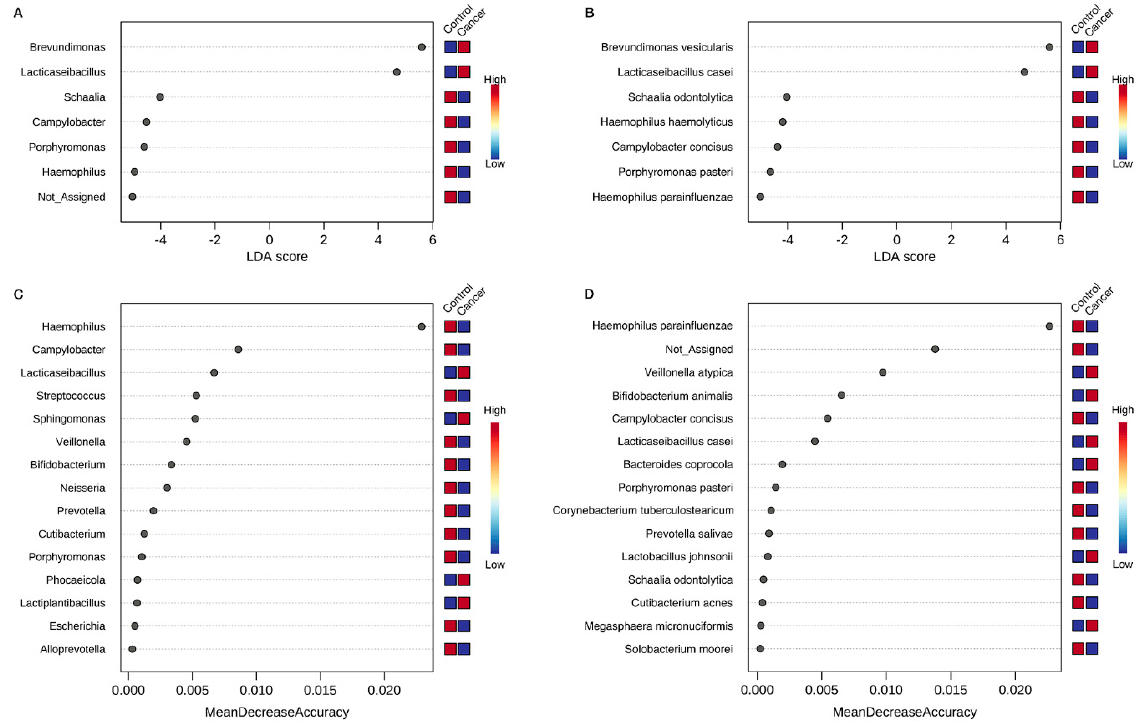
Figure 5. Taxonomic differences between control and cancer groups in linear discriminant analysis effect size (LEfSe) and random forest (RF) analyses. Linear discriminant analysis (LDA) score of differentially expressed bacteria obtained from LEfSe analysis of gastric microbiota in the control and cancer groups at the ( A ) genus and ( B ) species levels. Taxa with p < 0.05 from the Kruskal–Wallis test and LDA score > 3 are shown. In RF analysis, ( C ) the top 15 genera and ( D ) species with the highest discriminatory power between the control and cancer groups are listed. In both LEfSe and RF analyses, red fields indicate higher abundance and blue fields indicate lower abundance in the indicated group compared to the other group.